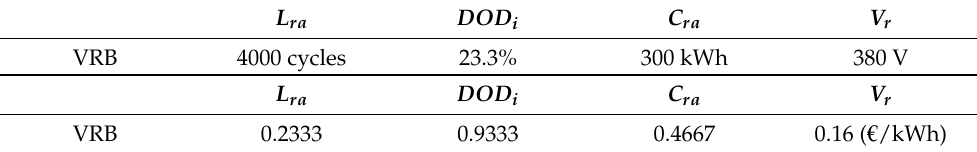
Table 4. Parameter table of VBR